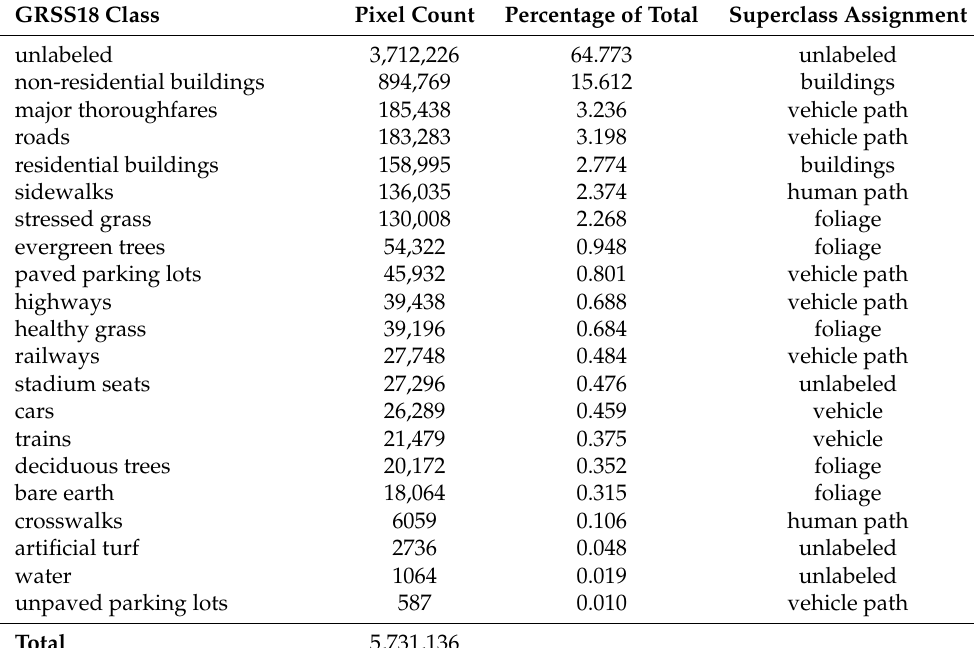
Table A1. GRSS18 class labeling scheme statistics and superclass labeling assignment.